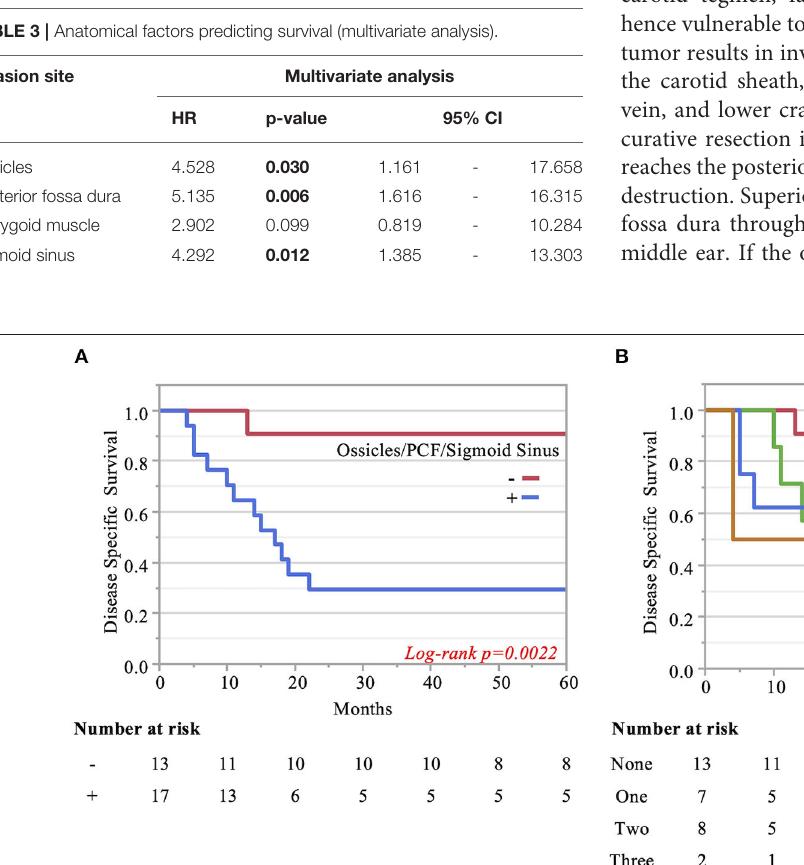
FIGURE 5 | Kaplan–Meier curves. (A) Two groups are compared: cases with invasion of at least one of the three significant structures and cases without invasion of any of these three factors. (B) Pterygoid muscle invasion, ossicle destruction, and invasion of the posterior fossa dura/sigmoid sinus are regarded as an anterior/inferior invasion marker, medial invasion marker, and posterior invasion markers, respectively. The impact of the number of invasion markers was analyzed among all three categories. The more markers, the poorer the patient disease-specific prognosis, which was statistically significant.